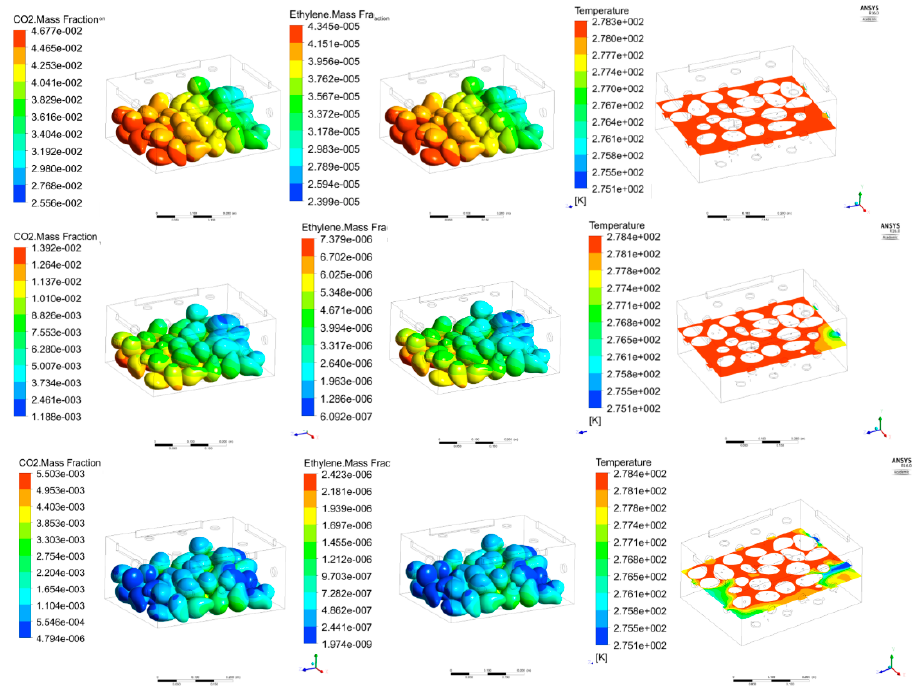
Figure 12. Contours of mass fractions and temperatures for avocadoes after 52 h of simulated storage time. The top row is for Re = 0.1, the middle row for Re = 1, and the bottom row for Re = 50, with airflow in the z direction.